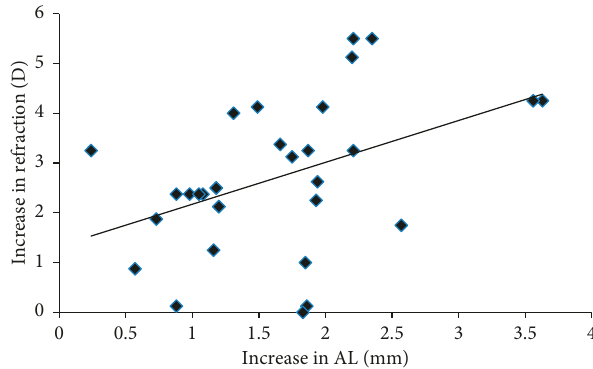
Figure 1: The correlation between myopia progression and axial elongation during the follow-up period in children. AL: axial length; D: diopter.